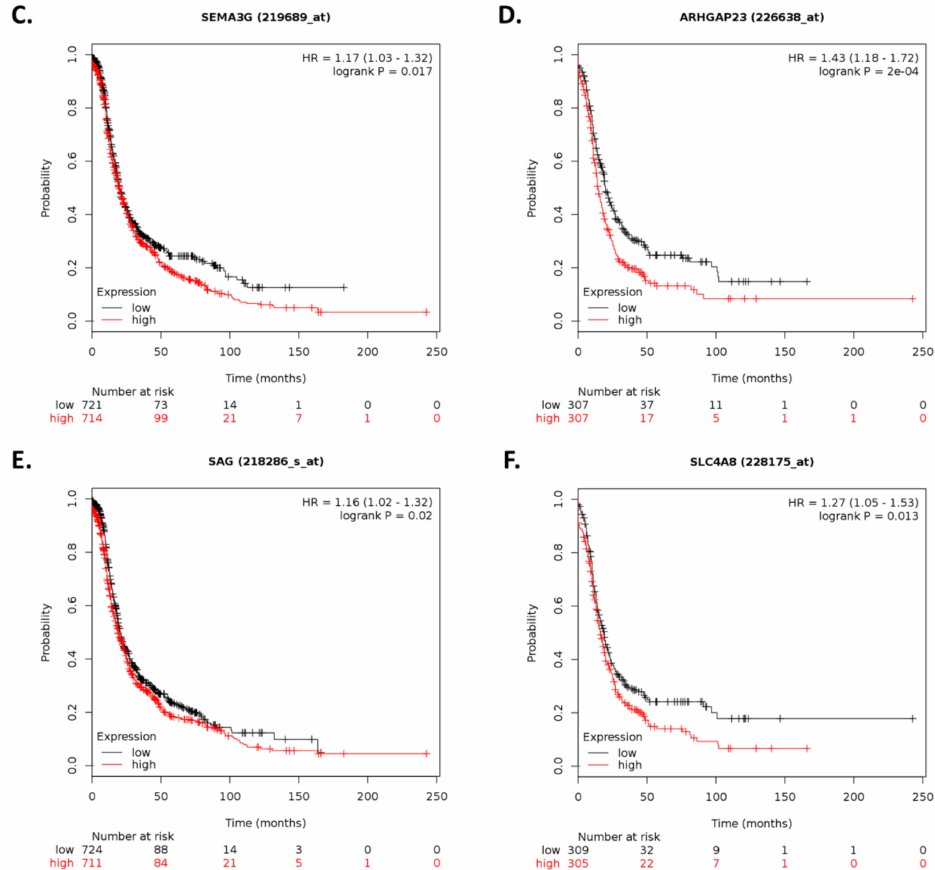
Figure 6. Kaplan–Meier plots for gene expression-based progression-free survival analysis. Survival plots of ovarian cancer patients were generated using Kaplan–Meier plotter (KM plotter). Progression-free survival (PFS) of patients with ovarian cancer stratified by expression levels of ( A ) CHGA , ( B ) BSN , ( C ) SEMA3G , ( D ) ARHGAP23 , ( E ) SAG , and ( F ) SLC4A8 are shown based on gene chip data. p -values < 0.05 were considered to be statistically